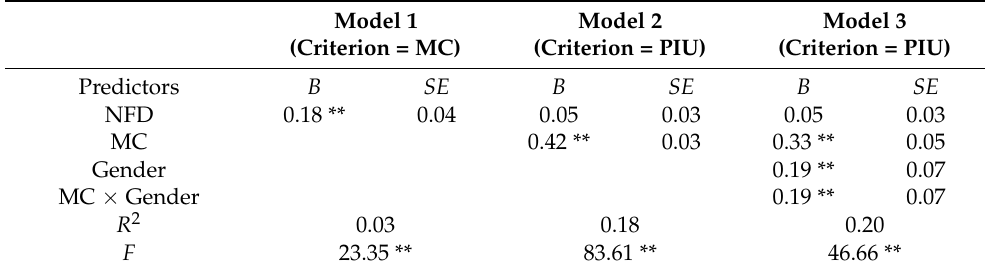
Table 2. Multiple regression analyses.